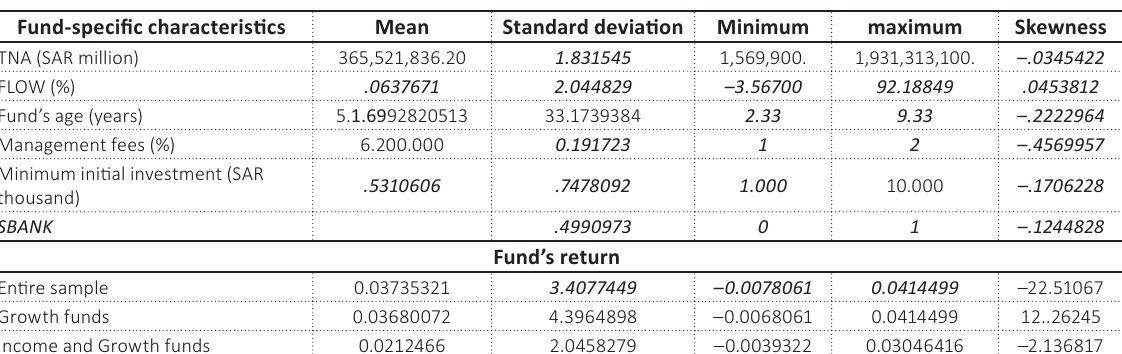
Table 1. Descriptive statistics on mutual fund-specific characteristics and subsample fund return